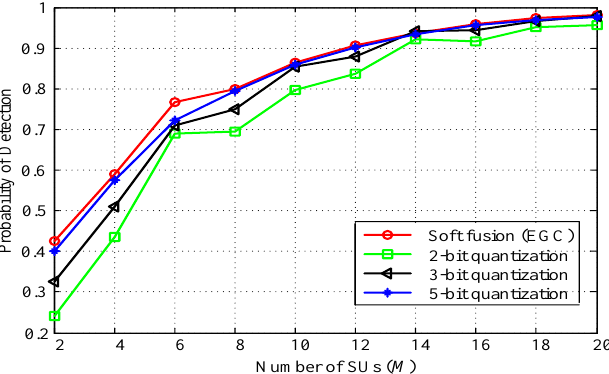
Figure 10. Probability of detection versus number of cooperative SUs ( Q f = 0.1, N = 300, SNR = − 12 dB).